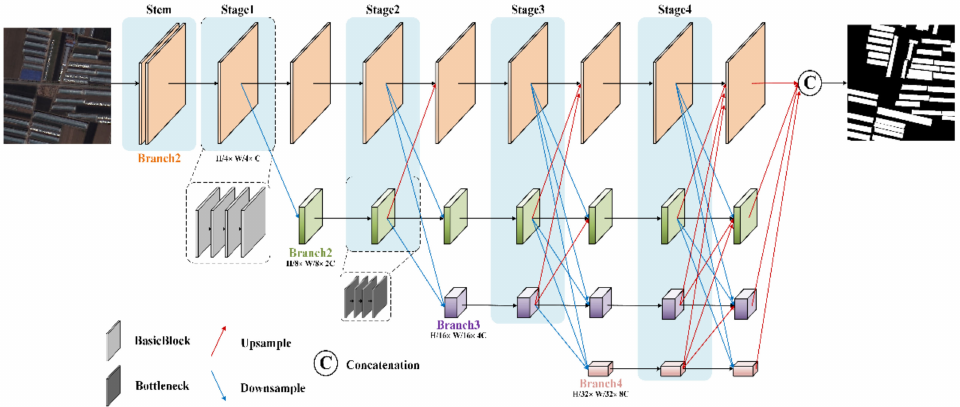
Figure 3. The structure of basic